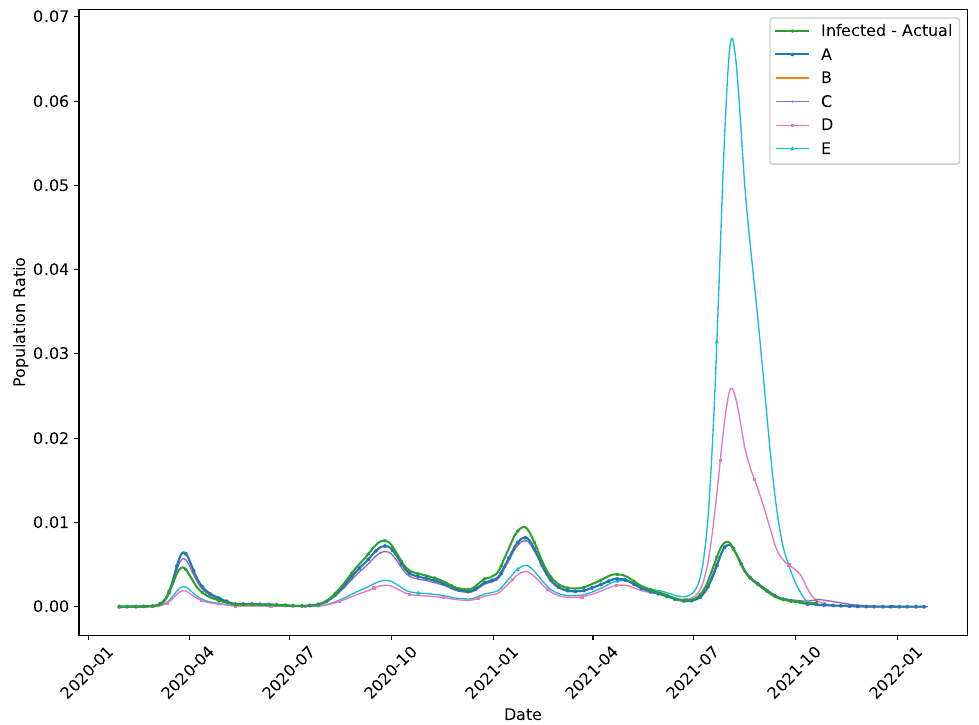
Figure 7. Numerical simulations of infected individuals ( I ) for